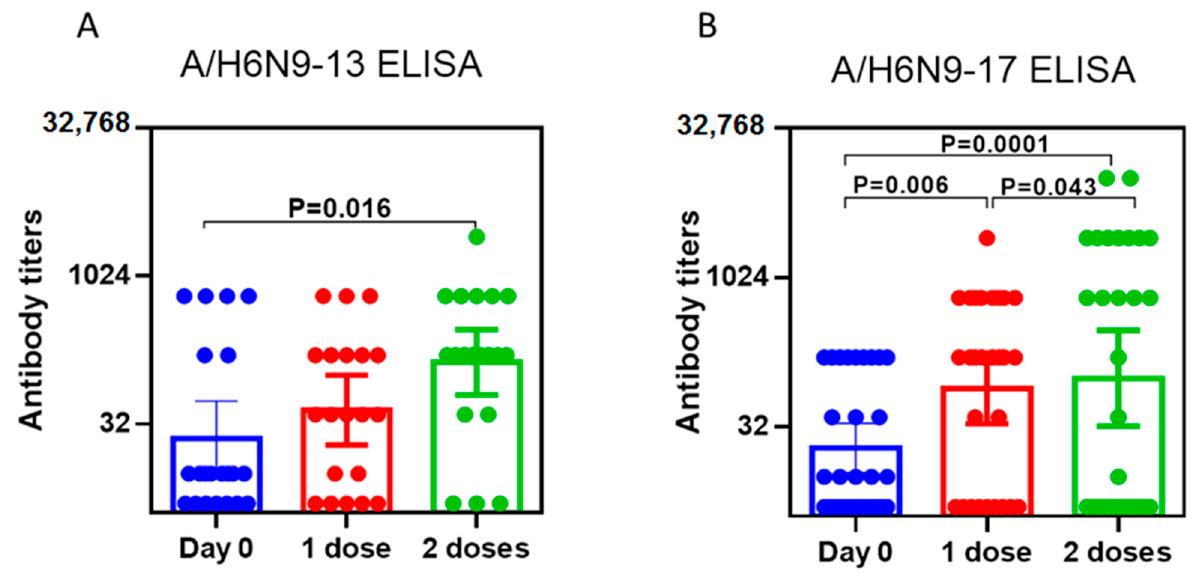
Figure 6. ELISA antibodies in the sera after A/H7N9 LAIV vaccination. ( A ) Immunization with A/Anhui/1/2013(H7N9)-based LAIV ( n = 29). ( A ) Immunization with A/Anhui/1/2013(H7N9)-based LAIV ( n = 29). Geometric means with 95% CI are presented ( B ) Immunization with A/Hong Kong/125/2017(H7N9)-based LAIV ( n = 30). Geometric means with 95% CI are presented.